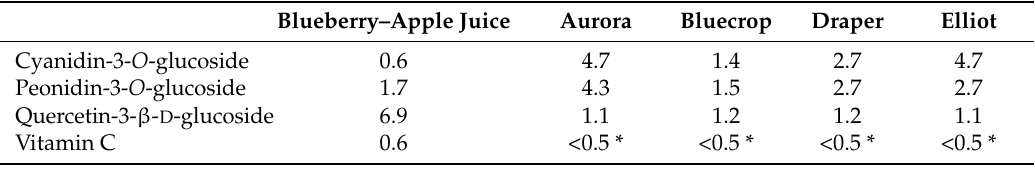
Table 1. Concentrations of bioactive compounds in blueberry–apple juice extract, and in extracts of different blueberry varieties, dissolved in medium at maximal concentration of 0.5% of the solvent 70% methanol/0.1% formic acid ( µ M). Blueberry–Apple Juice Aurora Bluecrop Draper Elliot Cyanidin-3- O